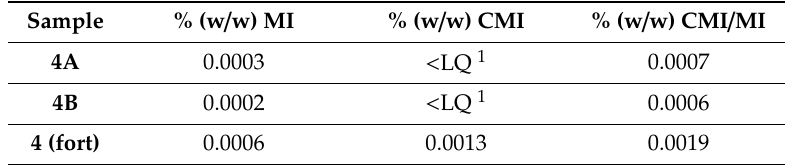
Table 6. Quantification of the CMI / MI mixture in a commercial shampoo and fortification with Kathon TM CG.